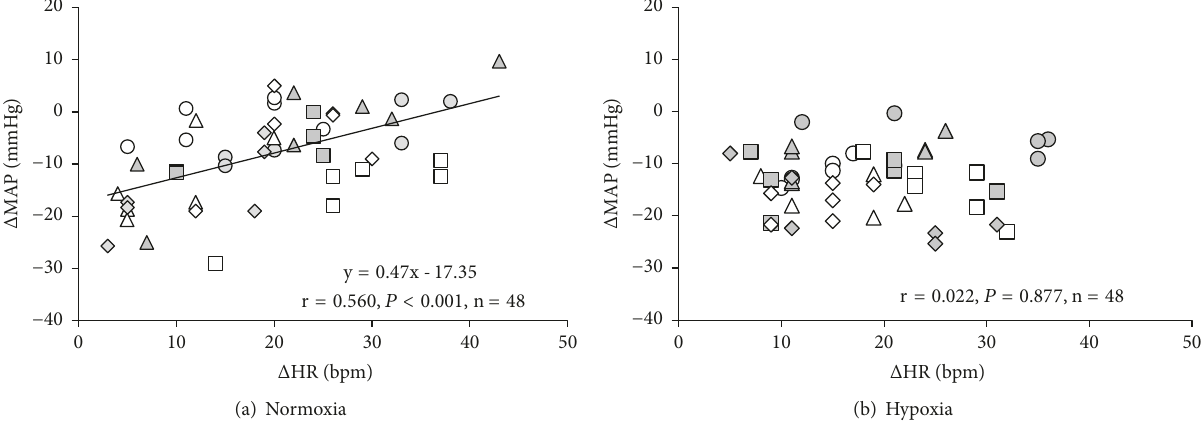
Figure 5: Relationship between changes in MAP and HR under normoxia (panel (a)) and hypoxia (panel (b)) when all data points during the recovery period are pooled. The changes in MAP and HR were calculated between the baseline values and each recovery period (10, 20, 30, 40, 50, and 60 min). Different symbols indicate each